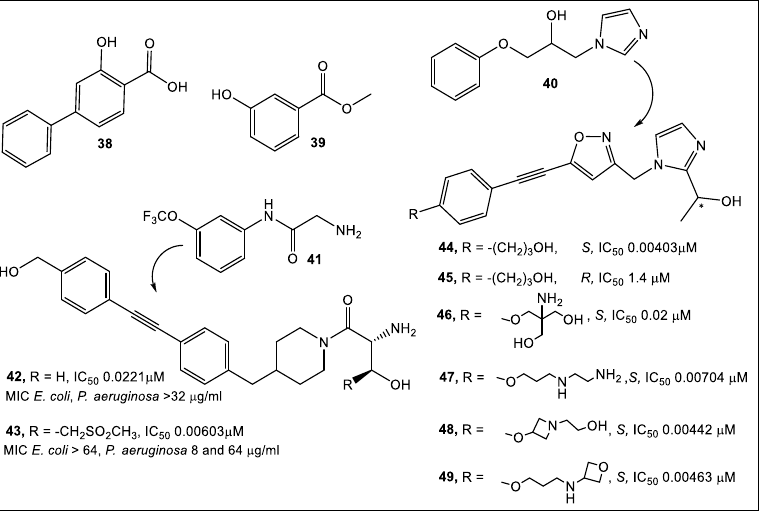
Figure 7. Fragments guide lead 41 derivatization where at low nanomolar concentration (enzyme functional assay) the glycine moiety complexes with zinc. Unfortunately, it has poor antimicrobial activity. Fragments guide lead 40 derivatization can through an imidazole moiety chelate zinc. Imidazole derivative 46 , obtained through structure-guided design, resulted in a 2-(1 S -hydroxyethyl)- which exhibits inhibition of LpxC at low nanomolar concentrations. In addition, 46 exhibits antimicrobial activity (minimal albumin effects) against Pseudomonas aeruginosa at a minimum inhibitory concentration (MIC) of 4 μg/mL [42].